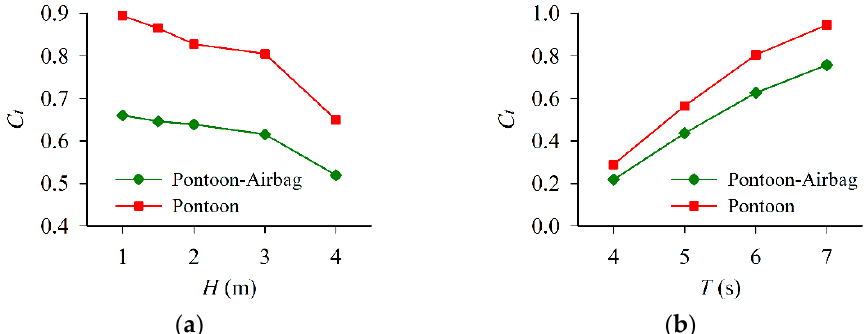
Figure 16. Comparison of the wave transmission coefficients C t of the double-row floating breakwater